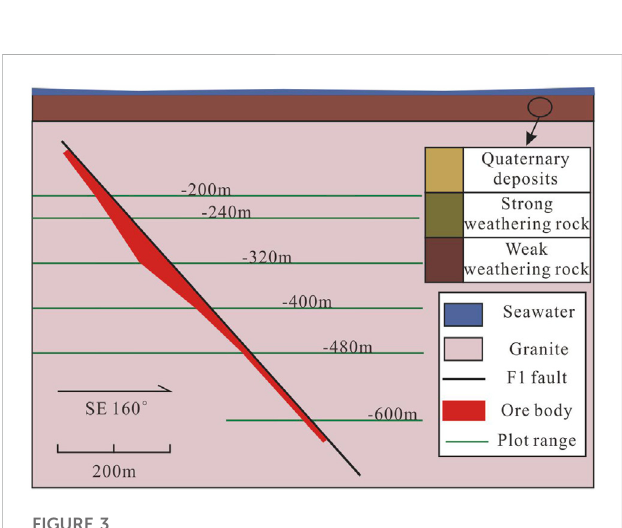
FIGURE 3 Simpli fi ed No. 55 prospecting pro fi le (Liu et al., 2022a).